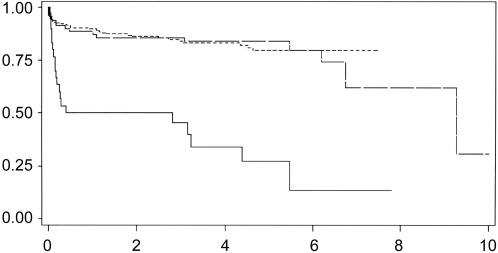
Survival analyses showing proportion of children without retinochoroiditis according to age in years when first eye lesion was detected in Brazil (solid line), and European neonatal (long dash) and prenatal centers (short dash).